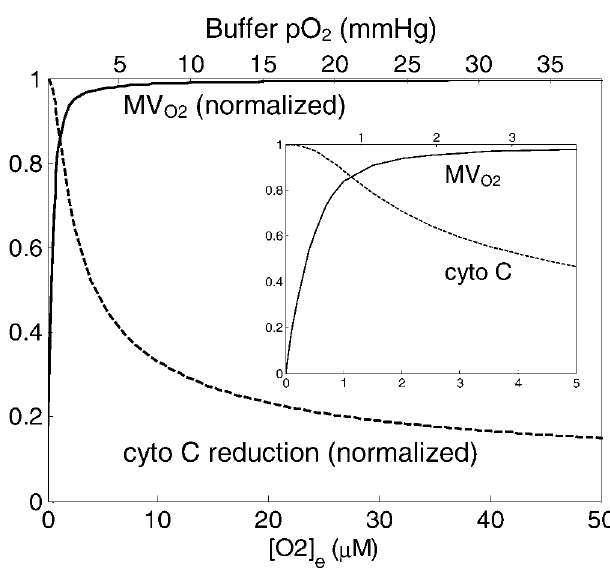
Figure 6. Behavior of Model at Low Oxygen Concentration Predicted rate of oxygen consumption (MV O2 ) normalized to maximal rate of oxygen consumption and fraction of cytochome c reduced are plotted against oxygen concentration, which is expressed in micromoles (lower axis) and oxygen partial pressure (upper axis). The oxygen consumption curve was computed for state-3 respiration, corresponding to experimental conditions reported in [18] and [19]. The cytochrome c curve corresponds to state-4 experimental conditions reported in [17]. Inset shows predicted curves for oxygen concentrations from 0 to 5 l M. DOI: